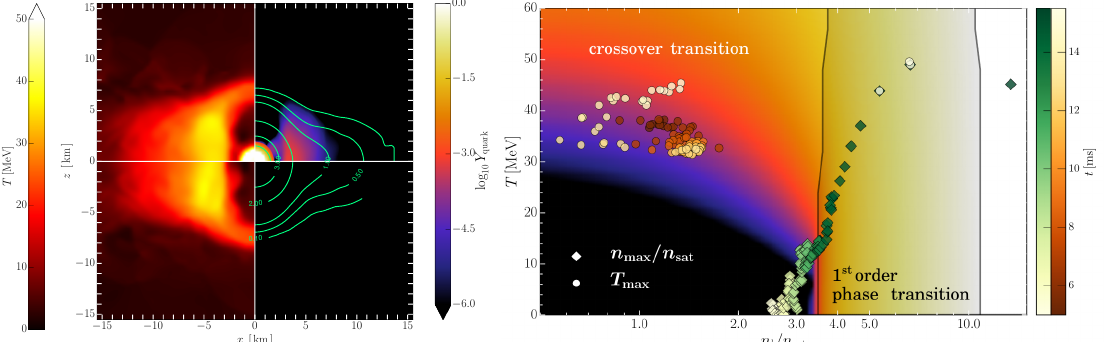
Figure 5. Left : merger simulations performed using the CMF model without (top) and with the suppression of quarks (bottom) for a high-mass binary at a time shortly before the collapse to a black hole (figure extracted from Ref. [20]). Right : time evolution of the maximum normalized baryon density region (diamonds) and maximum temperature region (circles) after the merger for the low-mass binary using the CMF EoS. The gray-shaded area shows the first-order PT being